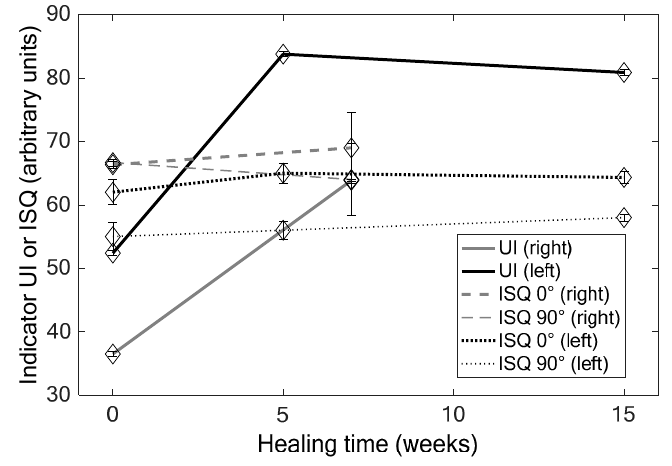
Figure 6. Results obtained for implant #2 right and left of the sheep #3 for the different healing times for UI , ISQ 0° and ISQ 90° values.